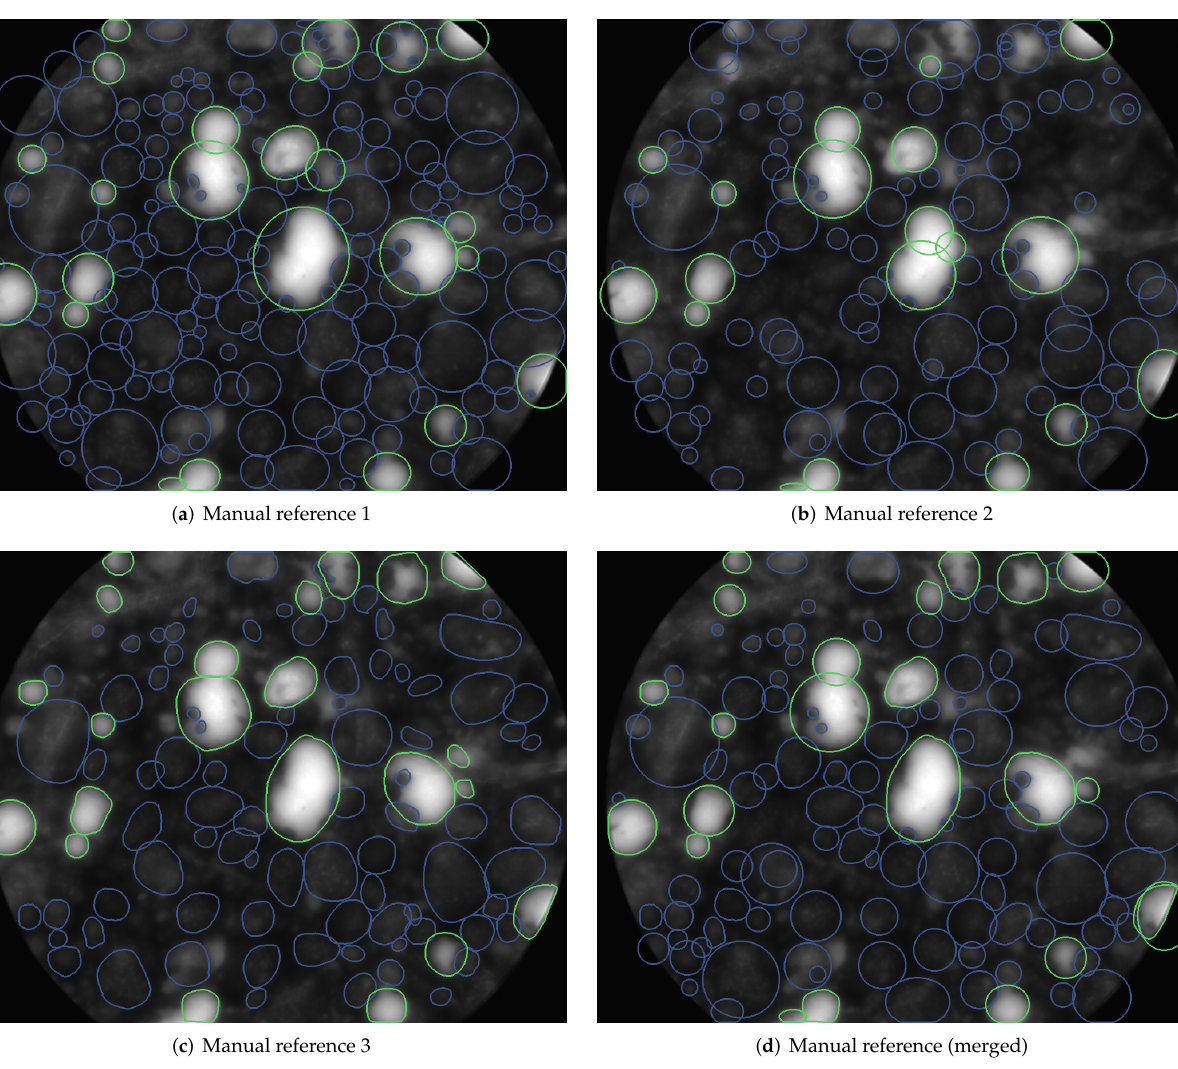
Figure 2. Exemplary annotations of manual reference measurements ( a – c ), as well as merged manual reference ( d